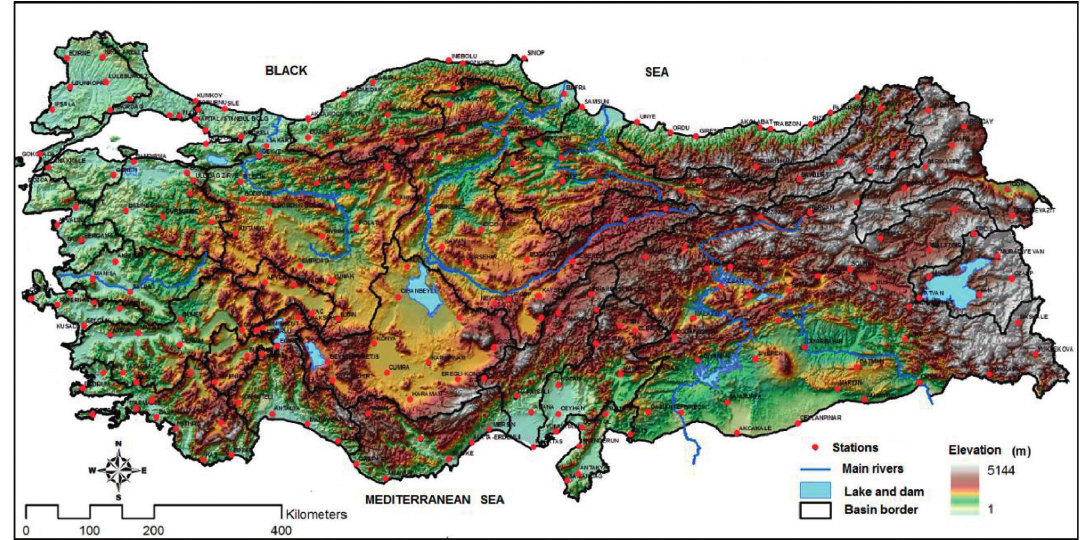
Figure 2: Elevation map of the study area